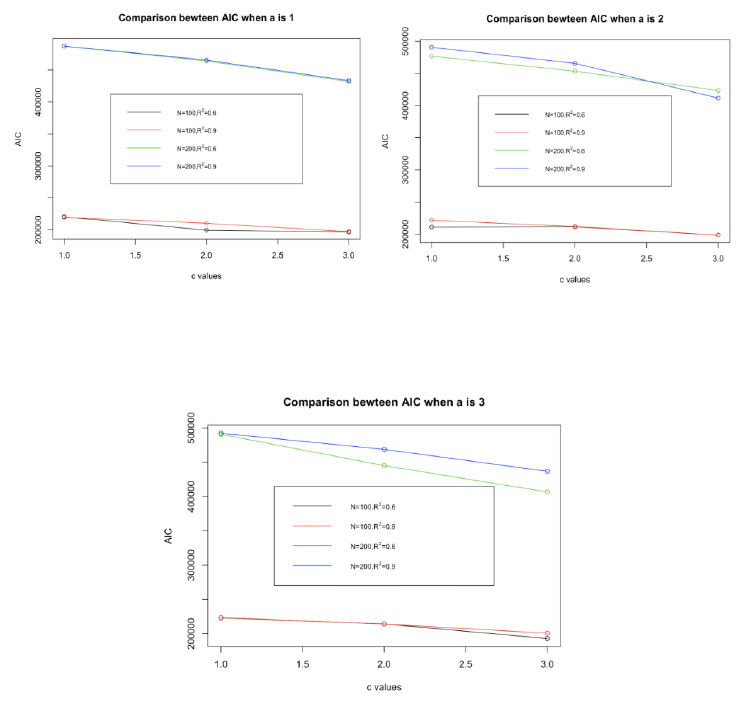
Figure 3. Comparison of AIC for selection of c ( a = 3, b = 1, d =